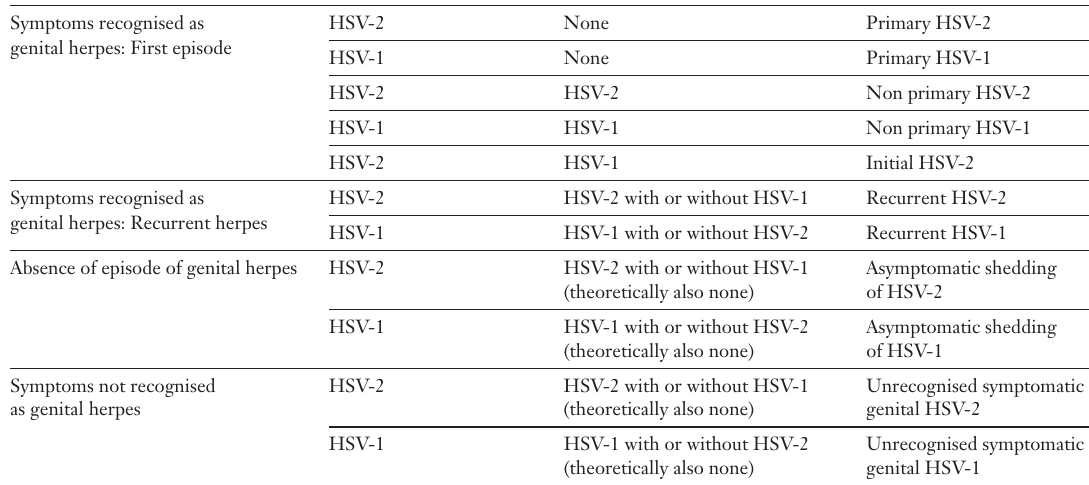
Different classifica- tions of genital herpes